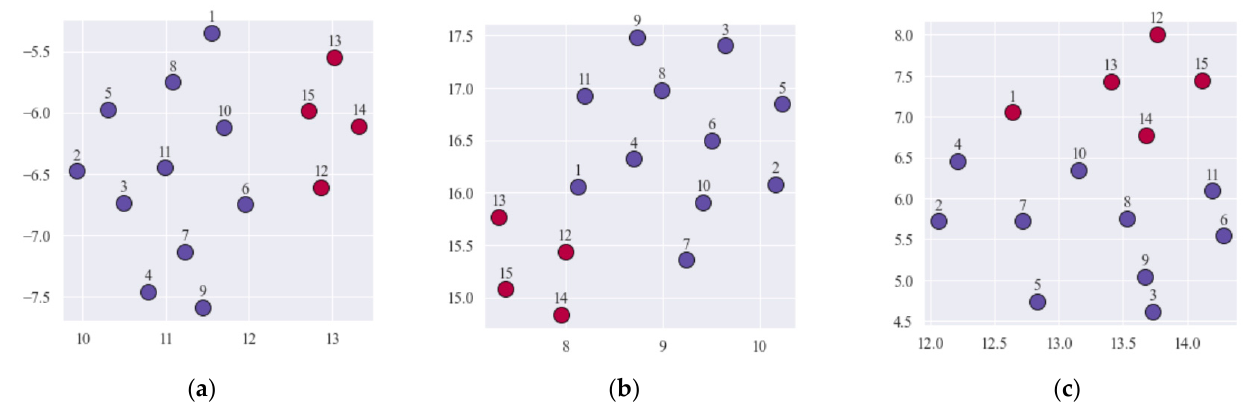
Figure 4. Results of visualization of clusters in the group of 15 CPs, represented by multisets: ( a )—purely risky assessment strategy (two clusters, the value of the cluster silhouette index is 0.460); ( b )—neutral assessment strategy (two clusters, the value of the cluster silhouette index is 0.260); ( c )—purely conservative assessment strategy (two clusters, the value of the cluster silhouette index is 0.249).